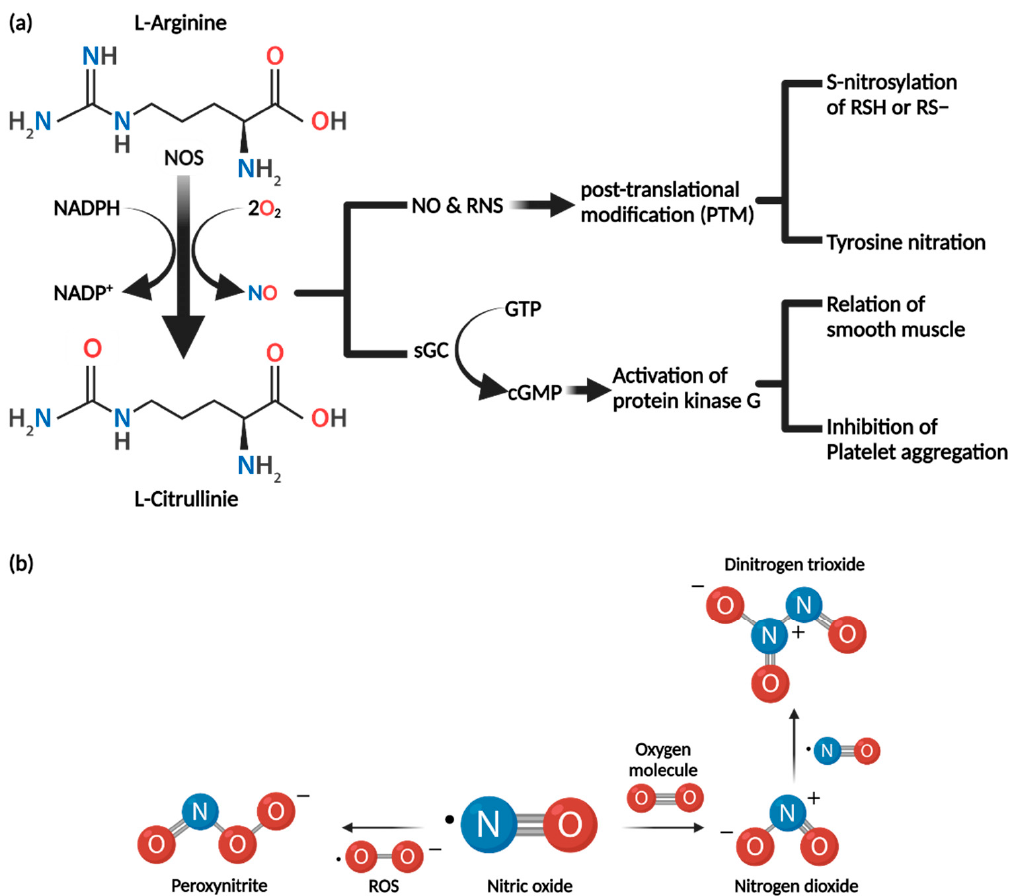
Figure 2. NO mechanism of synthesis and action. ( a ) NO is synthesized in the process of converting L-arginine to L-citrulline and is oxidized by NOS in the presence of O 2 and NADPH. There are two major mechanisms of action of NO: cGMP dependent and cGMP independent. The NO/cGMP pathway induces relaxation of smooth muscle and inhibits platelet aggregation. In the cGMP independent pathway, some NO is converted into reactive nitrogen species (RNS). NO and RNS mediate post-translational protein modification (PTM) by S-nitrosylation and tyrosine nitration. ( b ) Synthesis of dinitrogen trioxide (N 2 O 3 ) and peroxynitrite (ONOO − ).